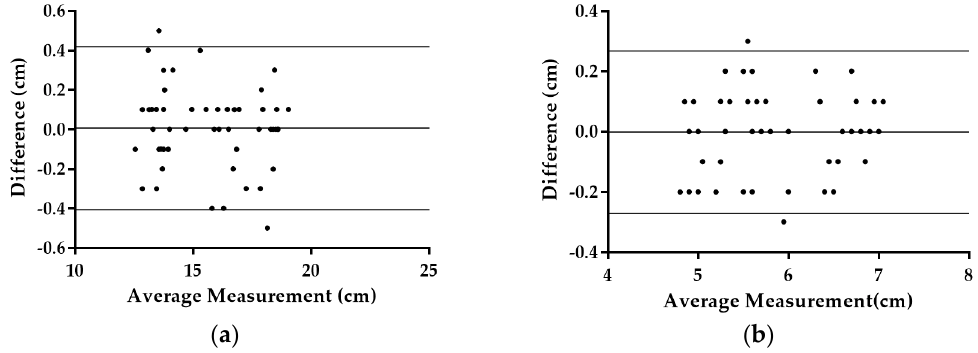
Figure 12. Bland-Altman plot for comparing difference and average of water displacement method and disk method; outer line indicate 95% limits of agreement and center line show the average difference. ( a ) Plot for length measurement; ( b ) Plot for height measurement.